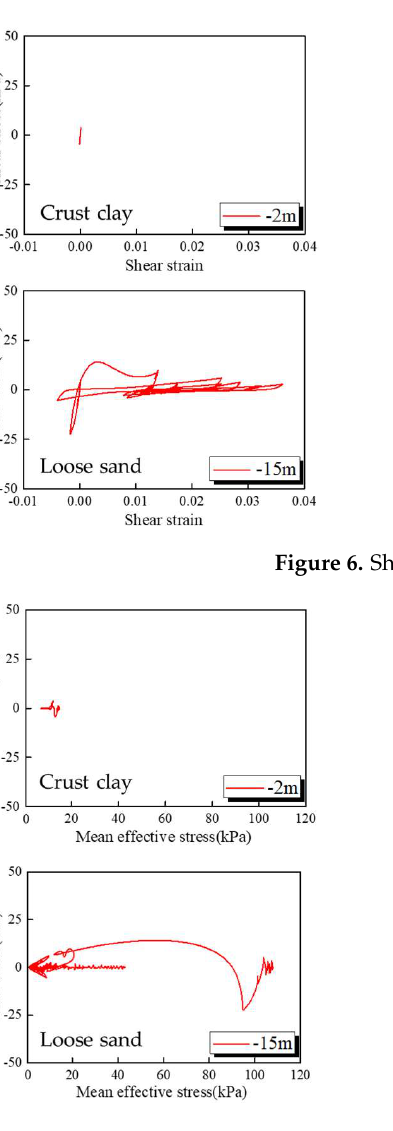
Figure 7. Effective stress paths under the Kobe motion.